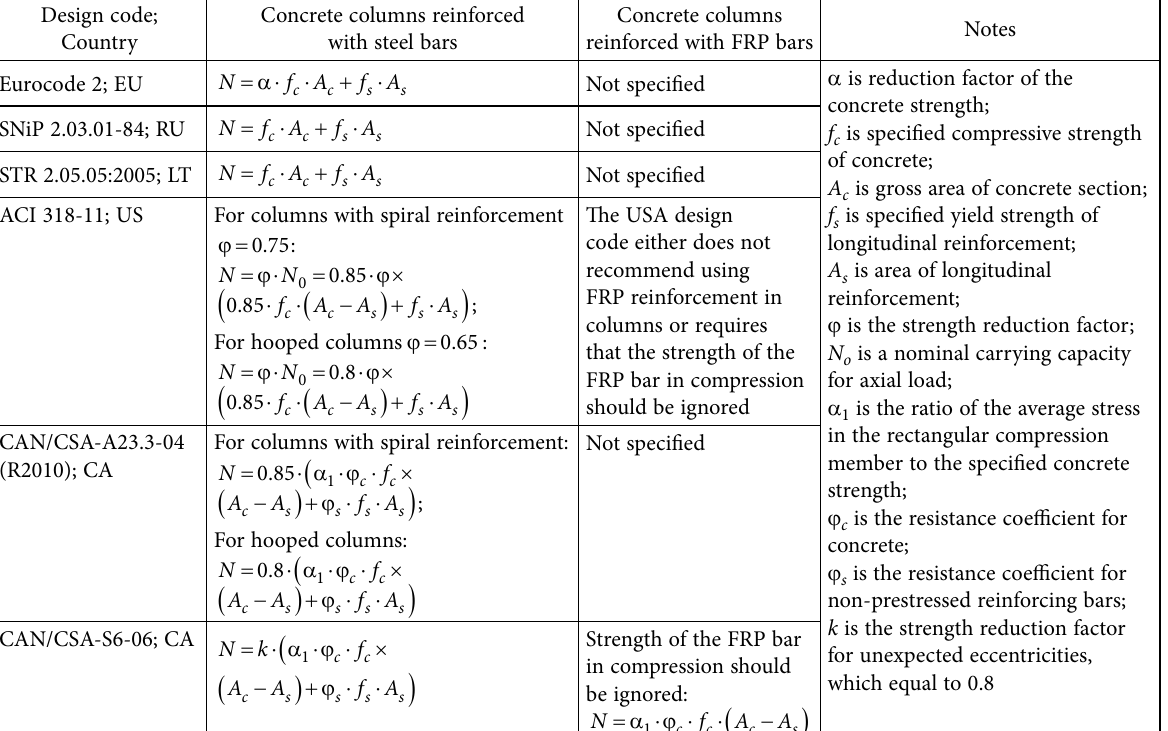
Table 3. Design codes’ requirements for carrying capacity of steel and FRP reinforced columns Design code;